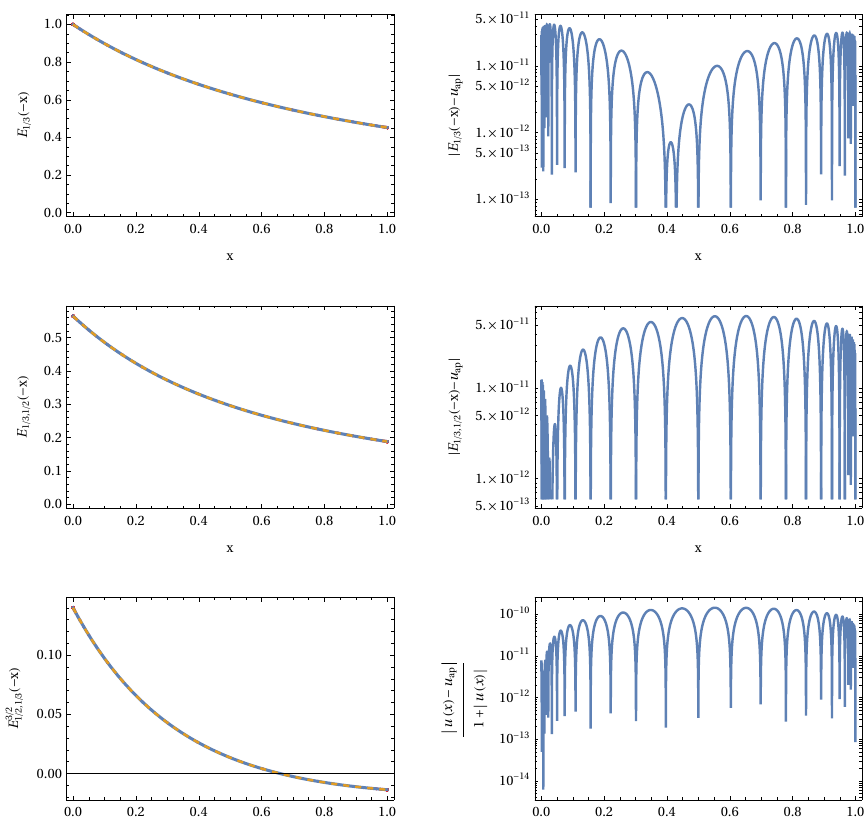
( x ) from top to bottom, left column Figure 3. Function representation for E α ( x ) , E α , β ( x ) , and E µ α , β with N = 56 Sinc points. The parameters α , β , and µ are indicated in the axis labels, respectively. The local errors are shown in the right column accordingly. For Prabhakar’s function we have to use a relative error because the exact representation is not available. The reference solution u ( x ) was computed with N = 128 Sinc points.